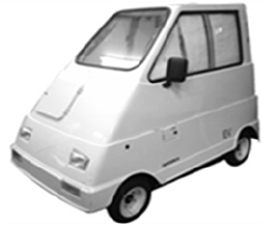
Figure 1. Ultra ‐ compact electric vehicle. Figure 1. Ultra-compact electric vehicle.